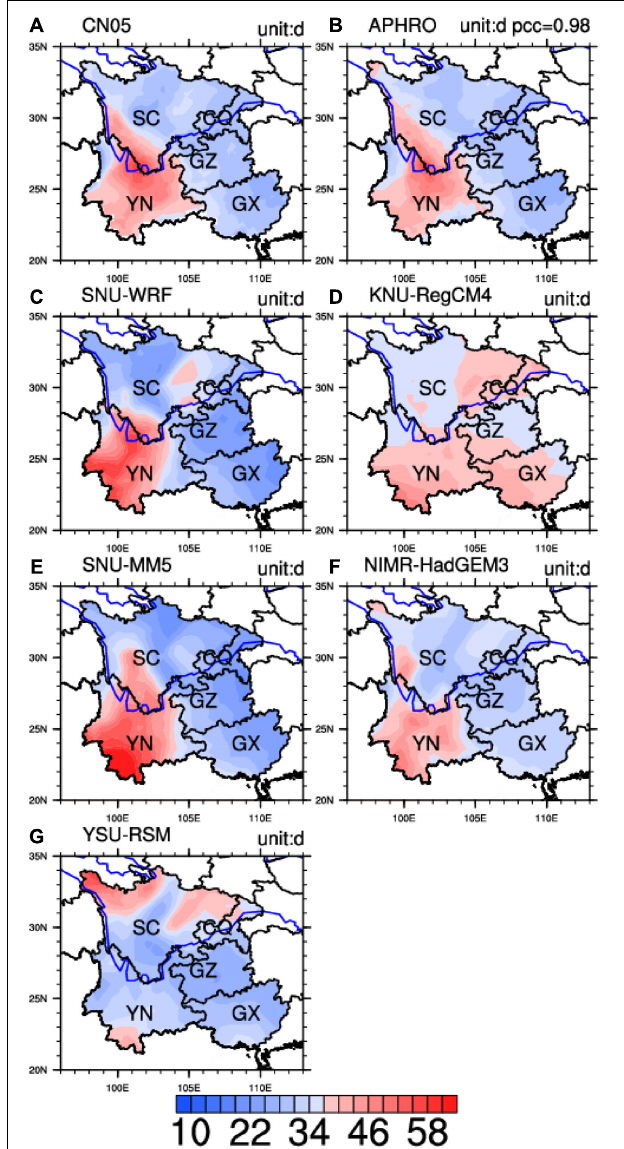
FIGURE 7 | Spatial distributions of interannual variability of the annual maximum dry spell length (AMDSL) (unit: day) from two observations: (A) CN05, (B) APHRO; and five RCM simulations: (C) SNU-WRF, (D) KNU-RegCM4, (E) SNU-MM5, (F) NIMR-HadGEM3, and (G) YSM-RSM.